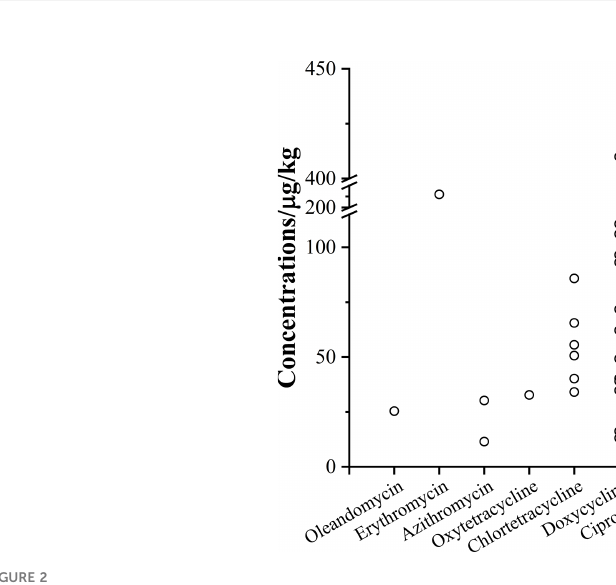
FIGURE 2 Concentrations of antibiotics in the positive